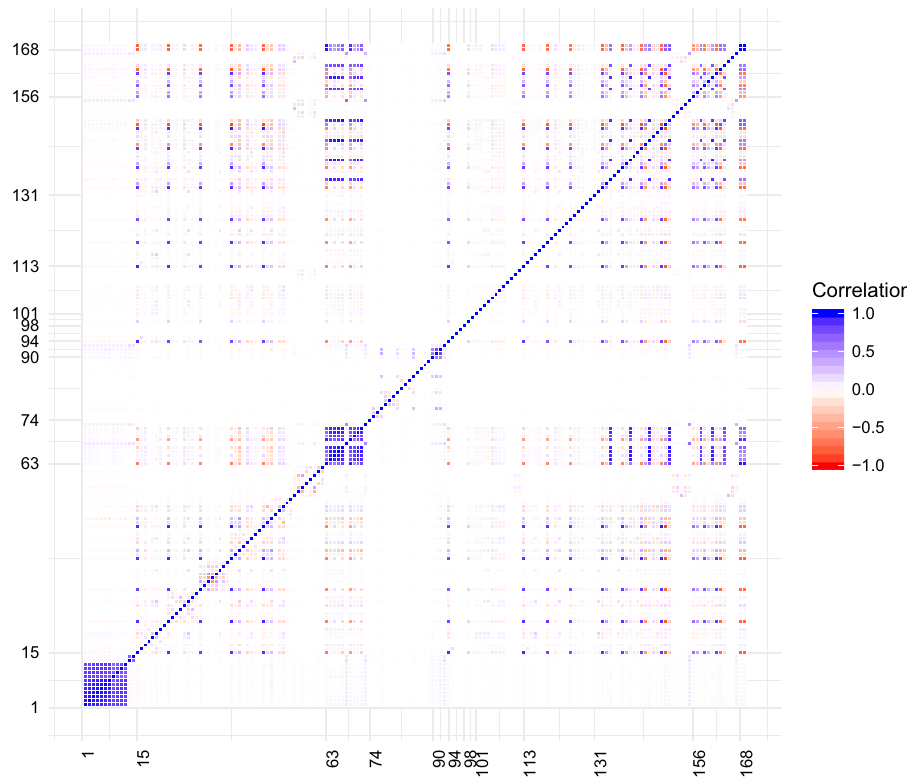
Fig. 3 Correlation map derived from the full covariance